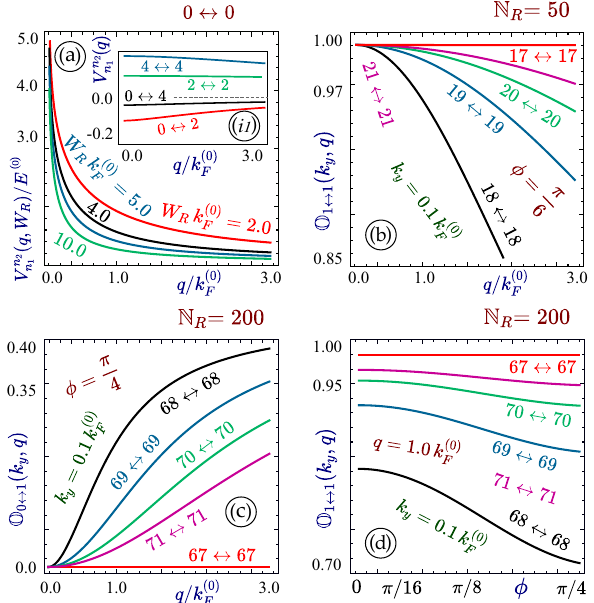
0 and n 2 0 as a ( i j m n q y W R ) with n 1 1 = − = = − = | | n 2 ) overlaps =